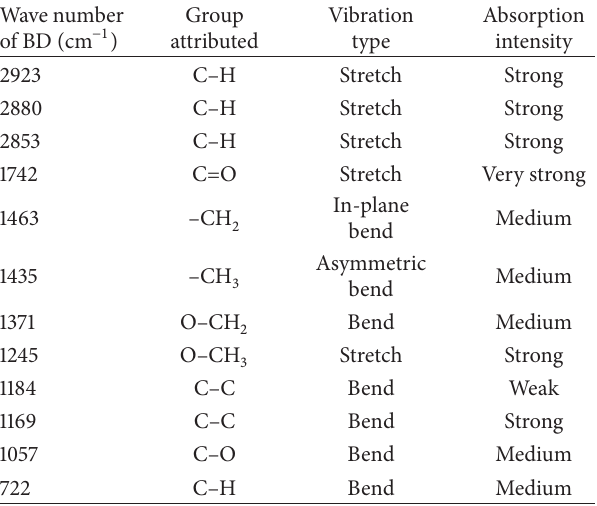
Table 3: Wave numbers responsible for different peaks of biodiesel